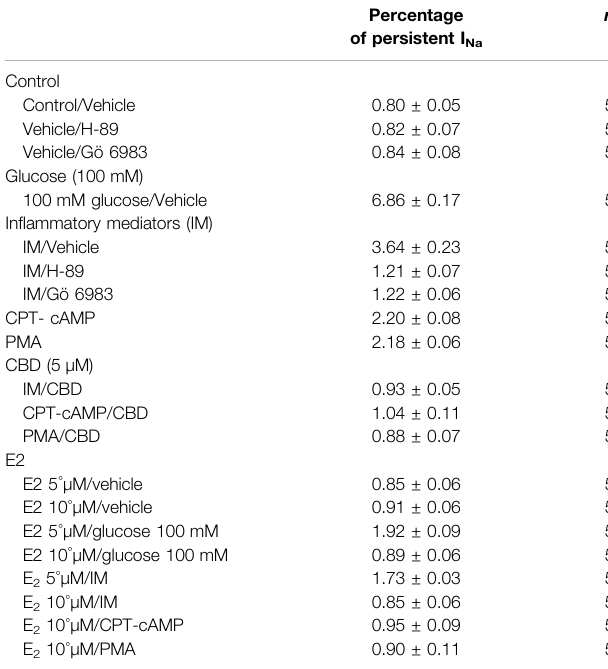
TABLE 4 | Persistent current.